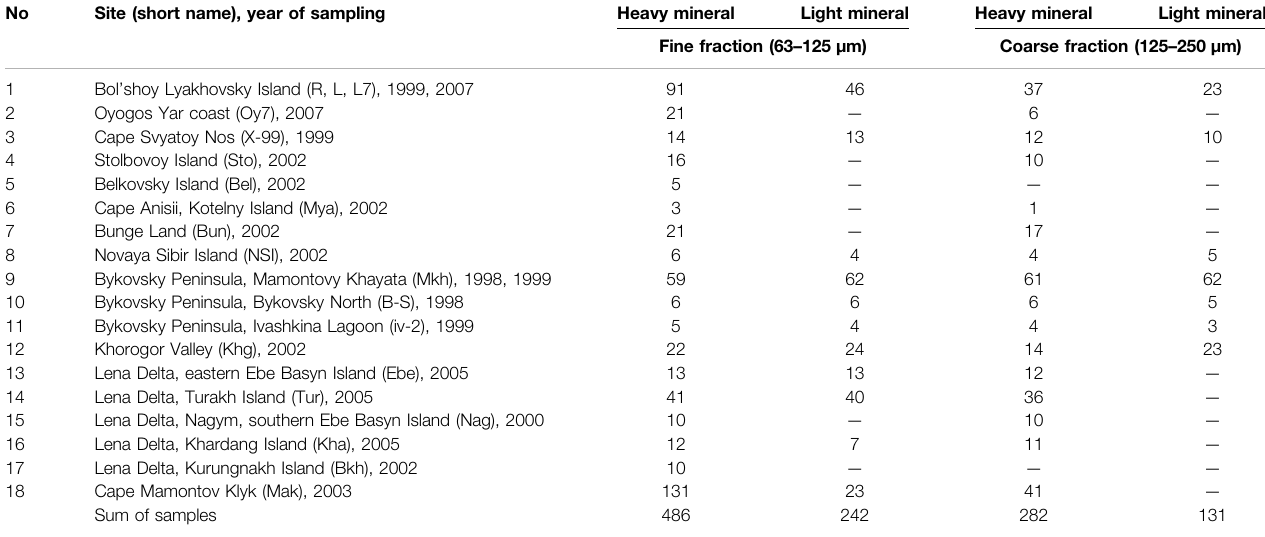
TABLE 2 | Number of analyzed samples per site and fractions (heavy and light minerals and grain-size